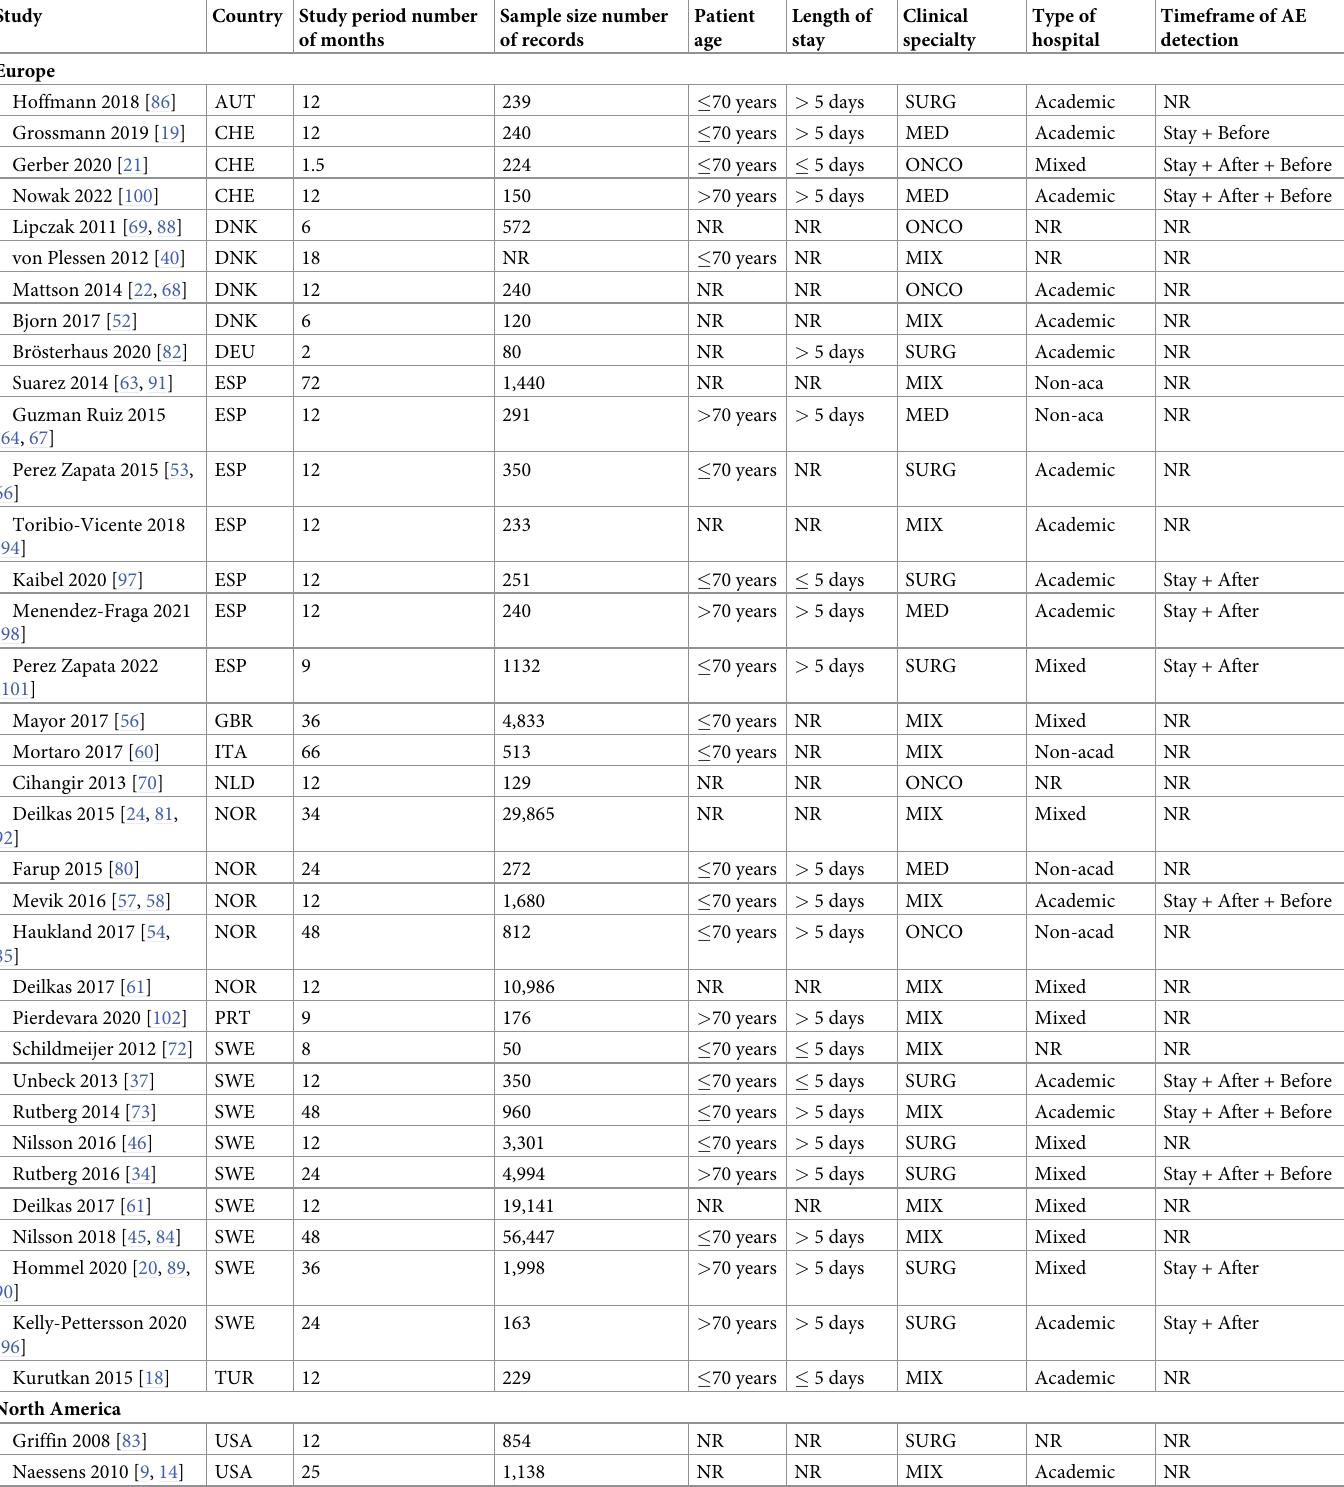
Table 2. Characteristics of the 54 included studies. Sorted by continent; within continent alphabetically by country code, and within the country by